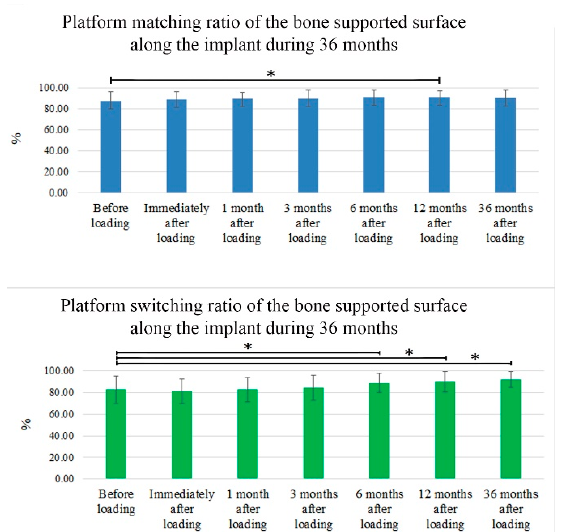
Figure 6. Ratio of the bone supported surface along the implant fixture over the 36-month period. Percentage of bone contact along the implant for 36 months of follow-up in the PM and PS implants. Asterisks (*) indicate a statistically significant difference ( p < 0.05).